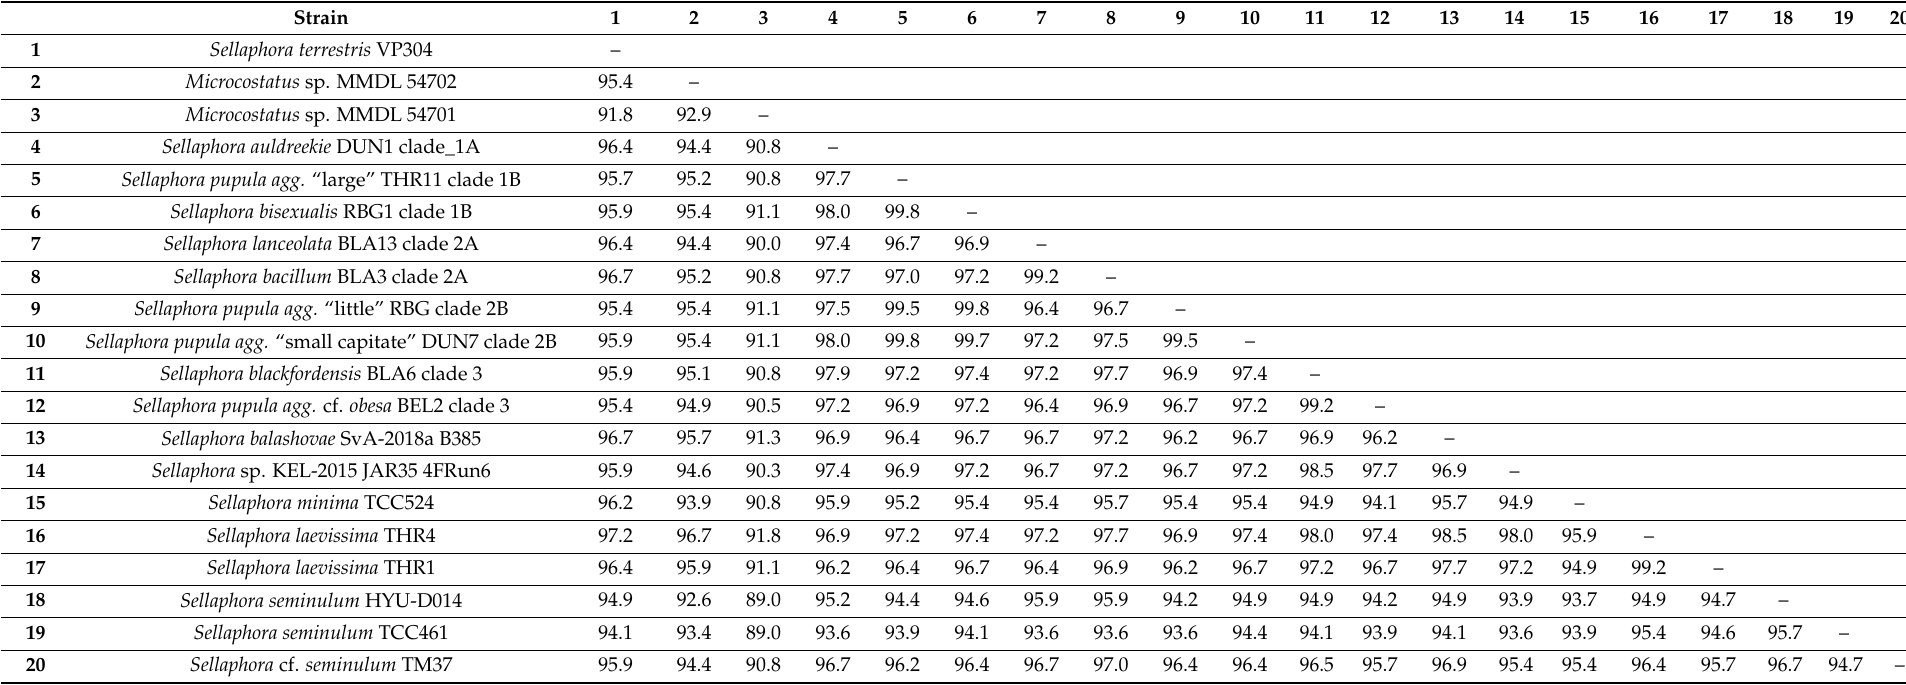
Table 2. Percentage similarity (p-distance) matrix of 20 strains on the basis of the partial 18S rRNA gene (401 bp).